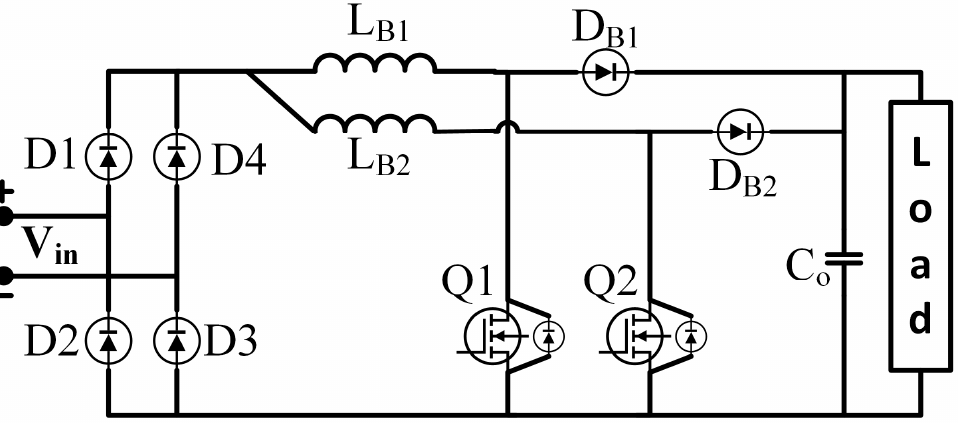
Figure 45. Interleaved Boost PFC Converter [46].